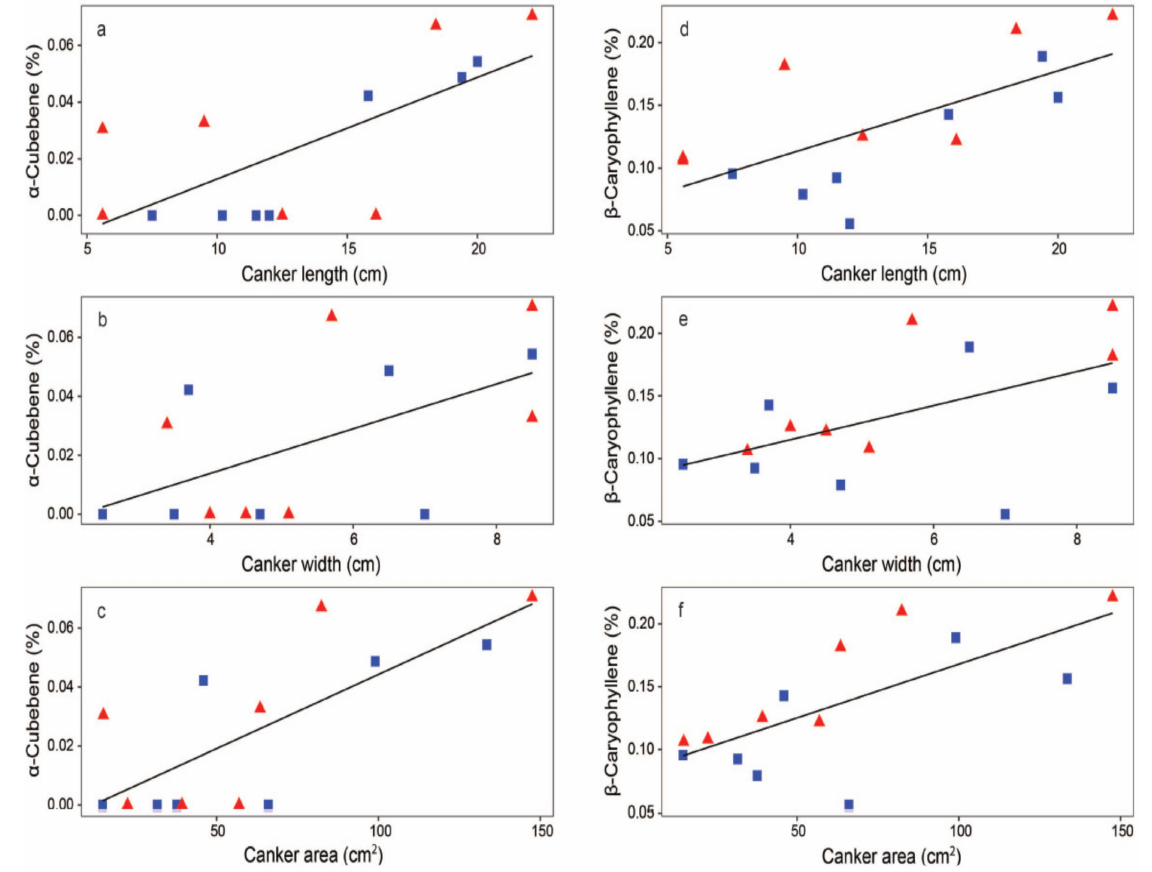
Figure 5. Correlations between bark canker size and leaf volatile sesquiterpenes identified in the hybrid poplar plants. ( a ) Relationship of canker length to the emission of α -cubebene. ( b ) Relationship of canker width to the emission of α -cubebene. ( c ) Relationship of canker area to the emission of α -cubebene. ( d ) Relationship of canker length to the emission of β -caryophyllene. ( e ) Relationship of canker width to the emission of β -caryophyllene. ( f ) Relationship of canker area to the emission of β -caryophyllene. Red triangles show the plants inoculated with Phytophthora cactorum ; blue squares show the plants inoculated with Phytophthora plurivora